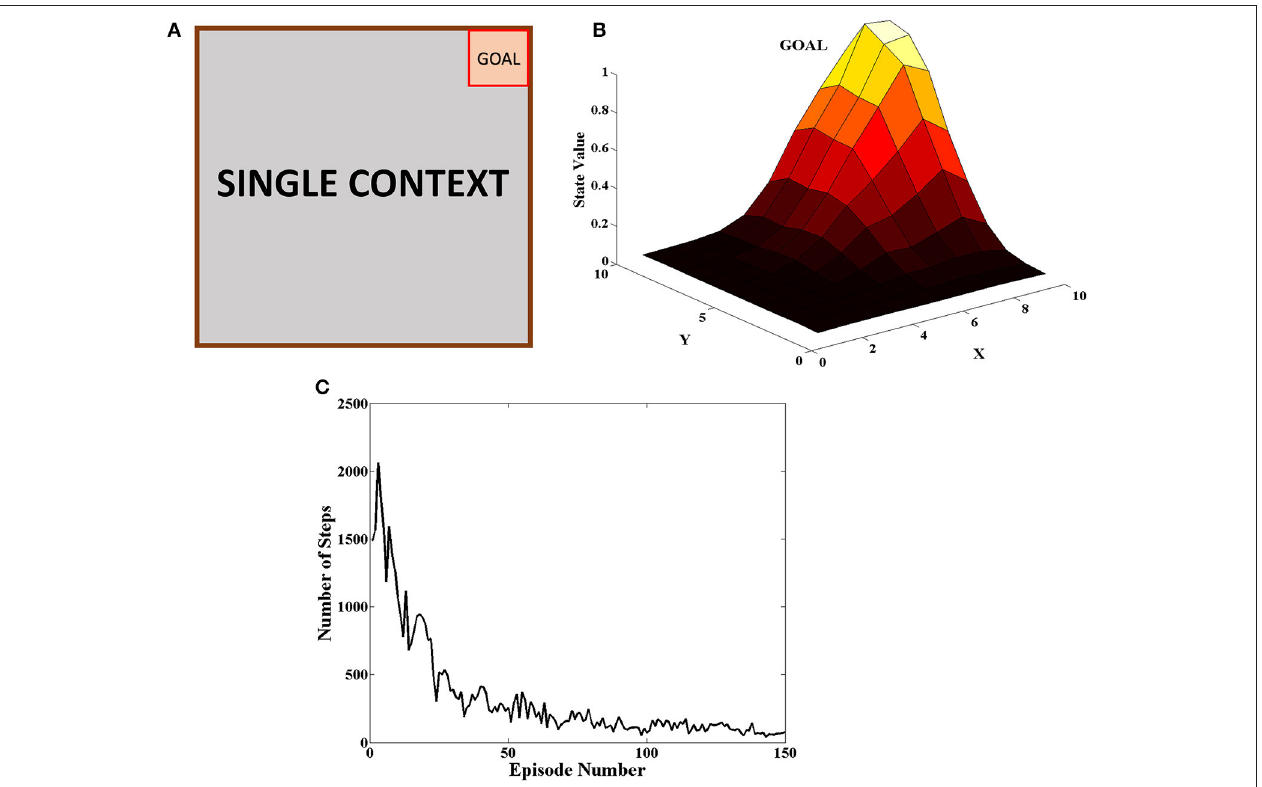
FIGURE 5 | (A) Schematic of the grid-world used in the task. A goal is located at the top right corner of the grid (B) State value map estimated by the agent at different spatial locations. We can see that the state value peaks at the goal location. (C) Plot of the Number of Steps taken by the agent in each episode averaged across 50 independent sessions. We see that the number of steps reduces as the agent learns across